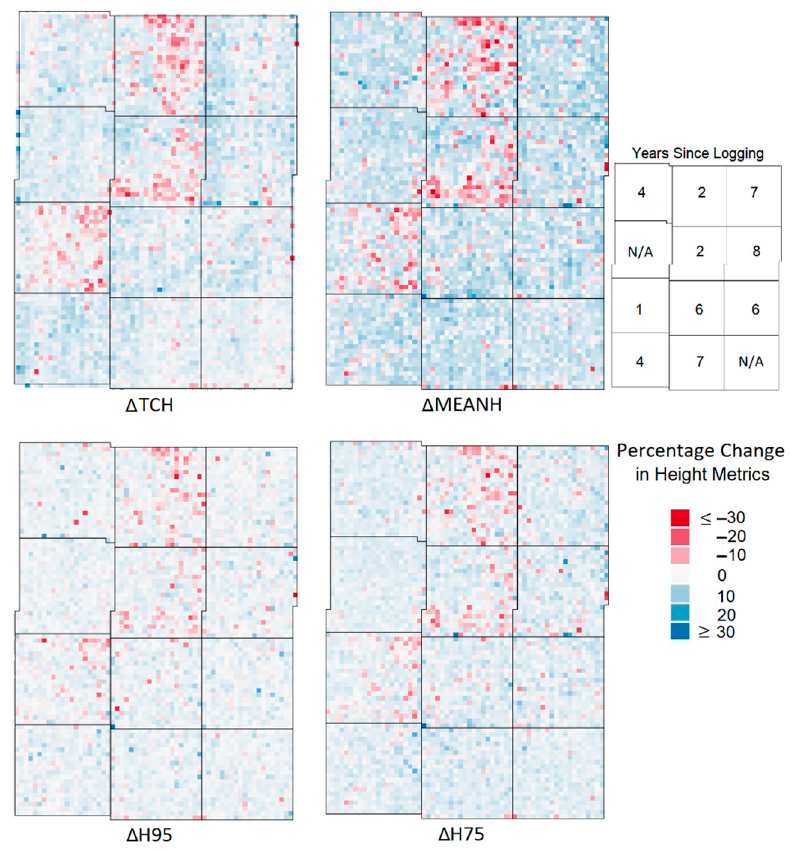
Figure 3. Maps of the percentage change in height metrics across the study area between 2012 and 2014 (resolution 50 m). Change is depicted by colour gradient with red representing the greatest negative change and blue the greatest positive change. ∆ TCH—top of canopy height, ∆ MEANH— mean height, ∆ H75 and ∆ H95—75th and 95th percentiles of height.